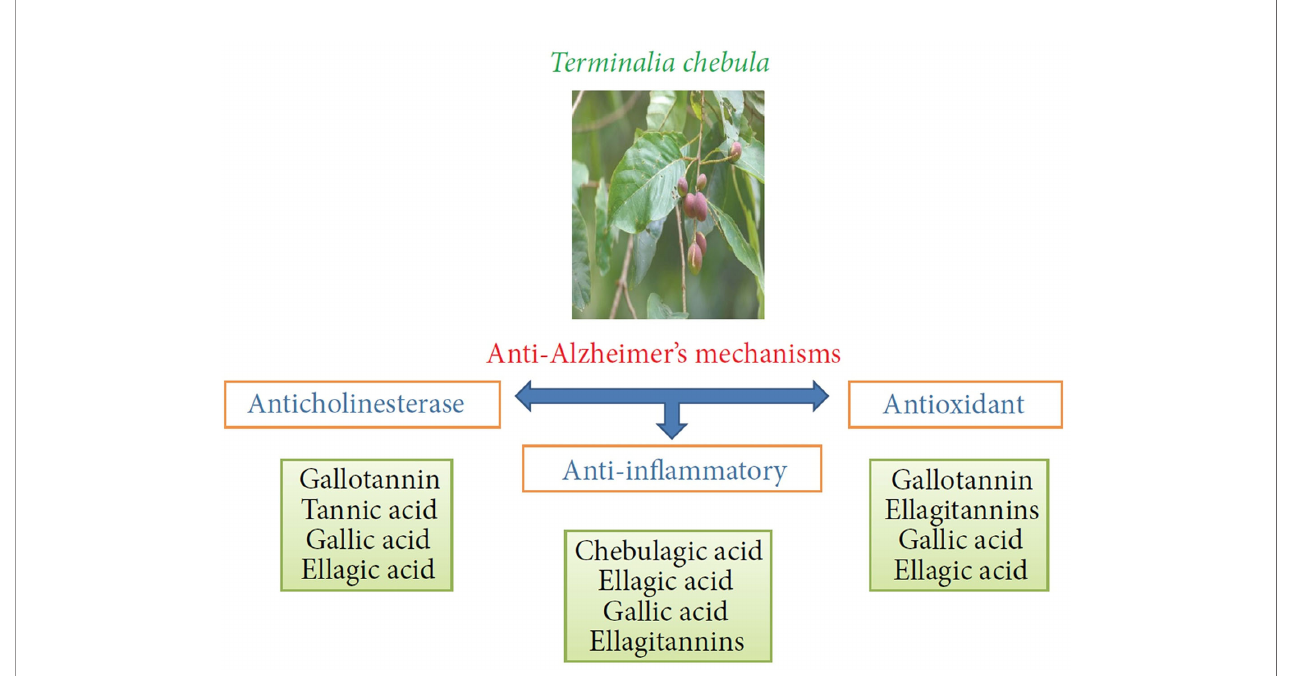
FIGURE 5 | Potential mechanism of anti Alzheimer ’ s therapy through the anticholinesterase, antiin fl ammatory, and antioxidant properties of T. chebula Retz. Reproduced under the Creative Commons Attribution License (Afshari et al.,